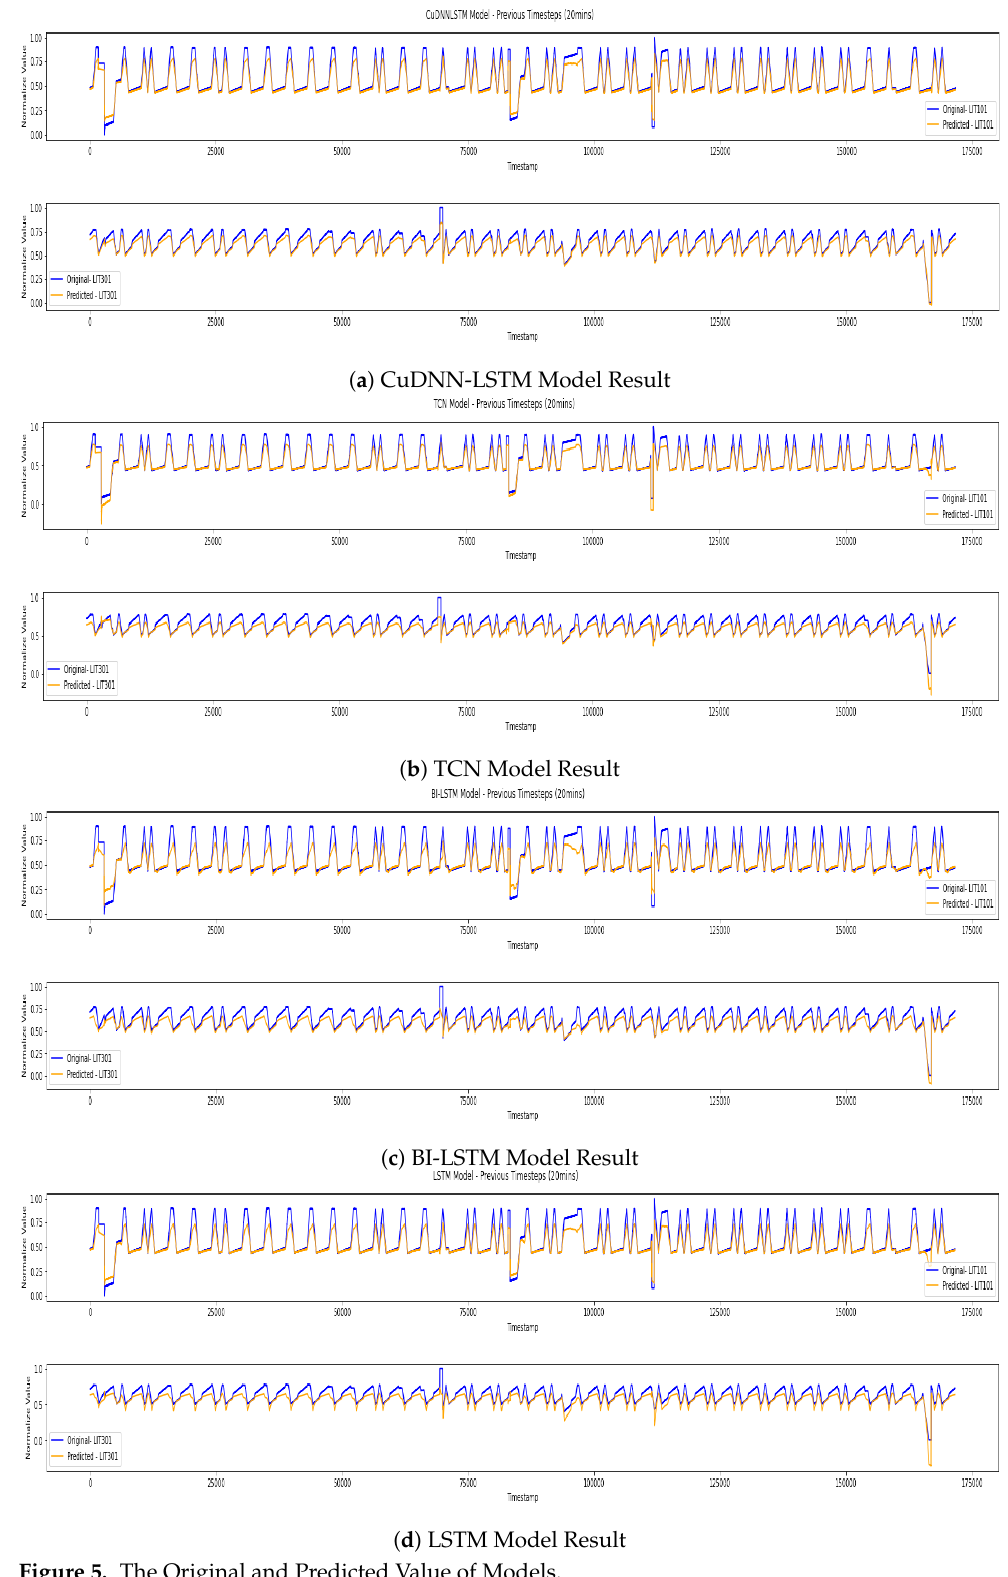
Figure 5. The Original and Predicted Value of